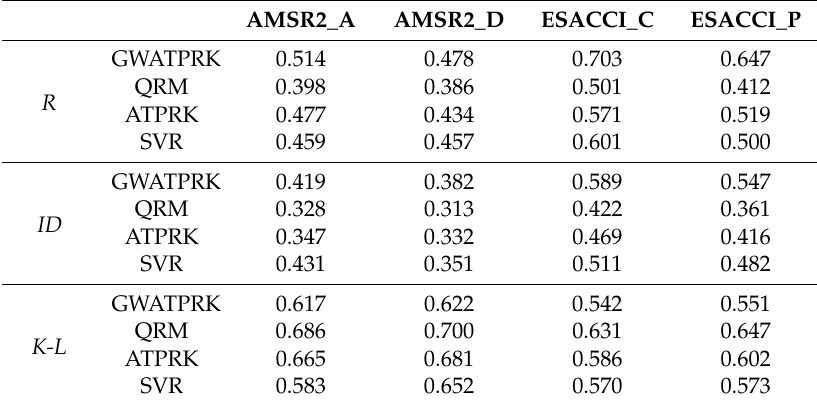
Table 4. Spatial statistics of comparisons between 1 km downscaled predictions and 1 km Tb data for the different cases in the upstream HBR